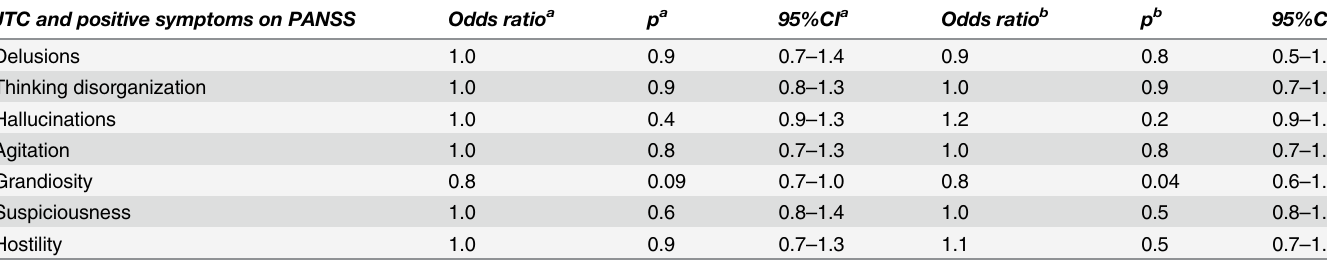
Table 4. Association between JTC and positive symptoms in patients with